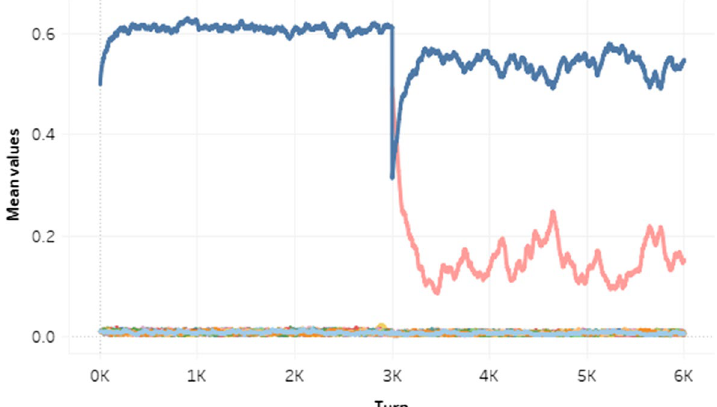
Fig. 4 Introduction of the cryptocurrency payments, case 1-A-2: Time series change of the mean of view. Case 1-A-2 is a case in which cryptocurrency can be selected as a utility (with the cryptocurrency agent), 1 unit is distributed to 50 people, all 50 people demand the cryptocurrency, and the view of 50 people is increased. Blue line is the fiat money good, red line is the cryptocurrency good, and other colors represent remaining goods. After turn 3001 of the cryptocurrency good introduction, the cryptocurrency good acquires a certain monetary function, which remains approximately 0.15, but this is far removed from that of the fiat money